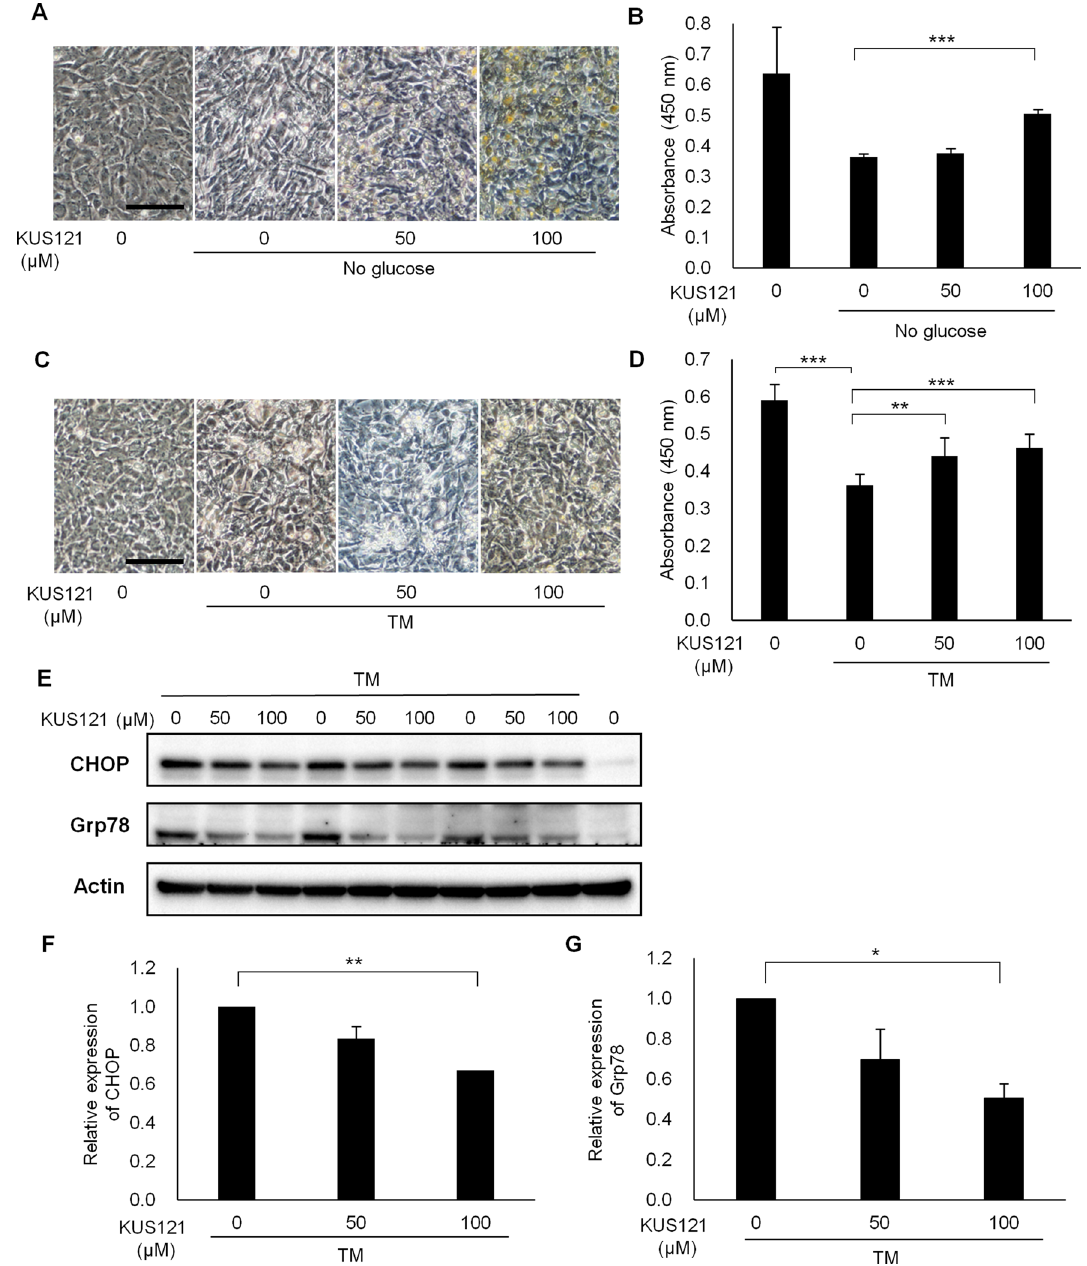
Figure 2. KUS121 reduces ER stress in ATDC5 cells. ( A , B ) Differentiated ATDC5 cells, cultured with KUS121 (0, 50 or 100 µM) for 5 days under glucose-free conditions. ( A ) Brightfield images of the cells. ( B ) Water-soluble tetrazolium (WST) assay results of ATDC5 cells are shown as optical density values at 450 nm. ***p < 0.001, vs no glucose without KUS121, Dunnett T3 test, N = 5. ( C , D ) Differentiated ATDC5 cells were cultured with tunicamycin (TM, 0.2 µg/mL) and KUS121 (0, 50 or 100 µM) for 40 h. ( C ) Brightfield images of the cells. ( D ) WST assay results of ATDC5 cells are shown as optical density values at 450 nm. **p < 0.01 and ***p < 0.001, vs TM without KUS121, Dunnett T3 test, N = 9. ( E – G ) Western blot analysis of differentiated ATDC5 cells, treated with TM (3 µg/mL) and KUS121 (0, 50 or 100 µM) for 6 h. ( F , G ) Expression levels of C/EBP-homologous protein (CHOP) and 78 kDa glucose-regulated protein (Grp78) were quantified and relative values were normalized to those of actin. Full-length blots are presented in Supplementary Fig. 2B. *p < 0.05 and **p < 0.01, vs TM without KUS121, Dunnett T3 test, N = 3. Error bars indicate standard deviation. Scale bars, 50 µm in ( A ) and ( C